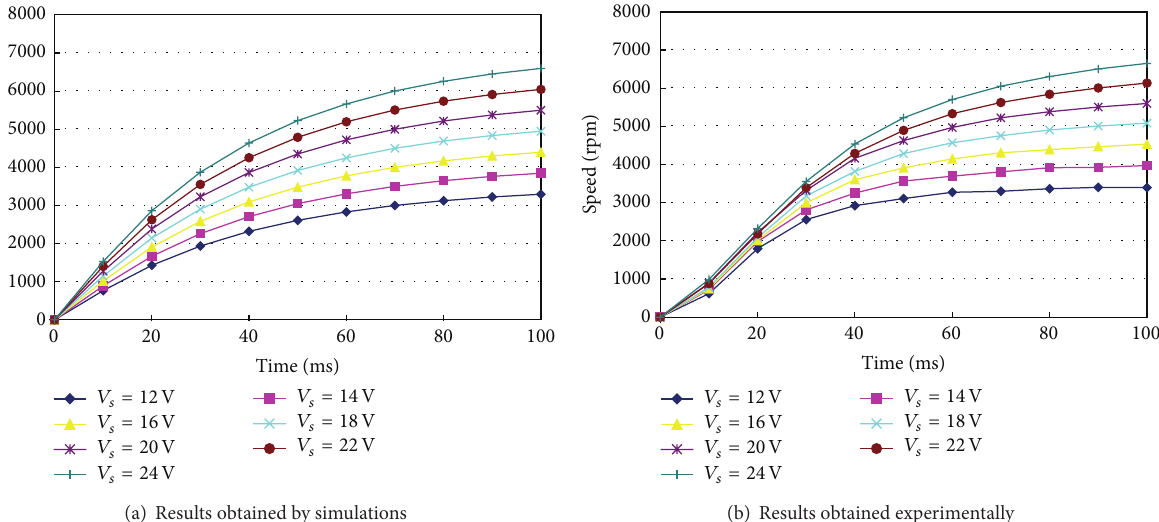
Figure 6: Step response of the linear motor speed.